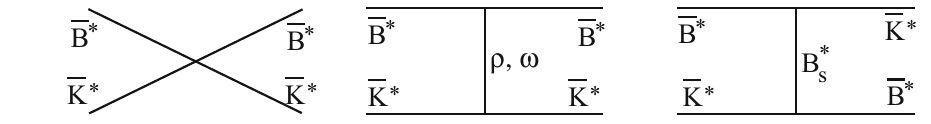
Fig. 6 Contact term and vector meson exchange for the ¯ B ∗ ¯ K ∗ potential